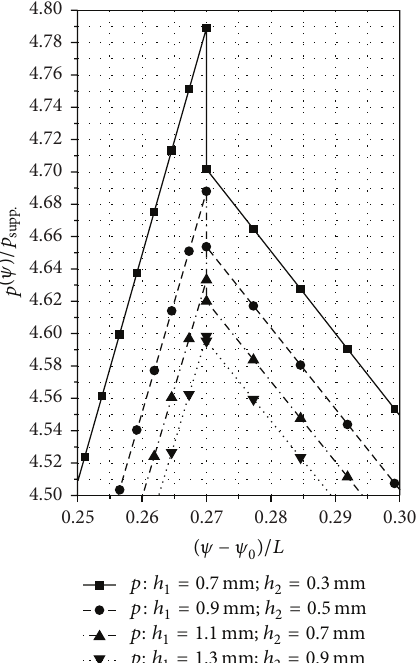
Figure 8: Detail of Figure 6 concerning the speed jump between ℎ ℎ 1 and 2 . (The marked points are those where we made the